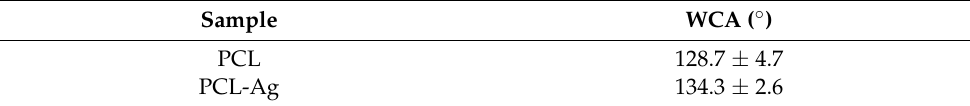
Figure 6. Photographs of water droplet on PCL surface before ( a ) and after Ag deposition ( b ). Photograph of diiodomethane droplet on blank PCL surface ( c ), as representative of both PCL and PCL-Ag surfaces. Table 2. Water contact angles (mean ± standard deviation) of PCL and PCL-Ag samples.